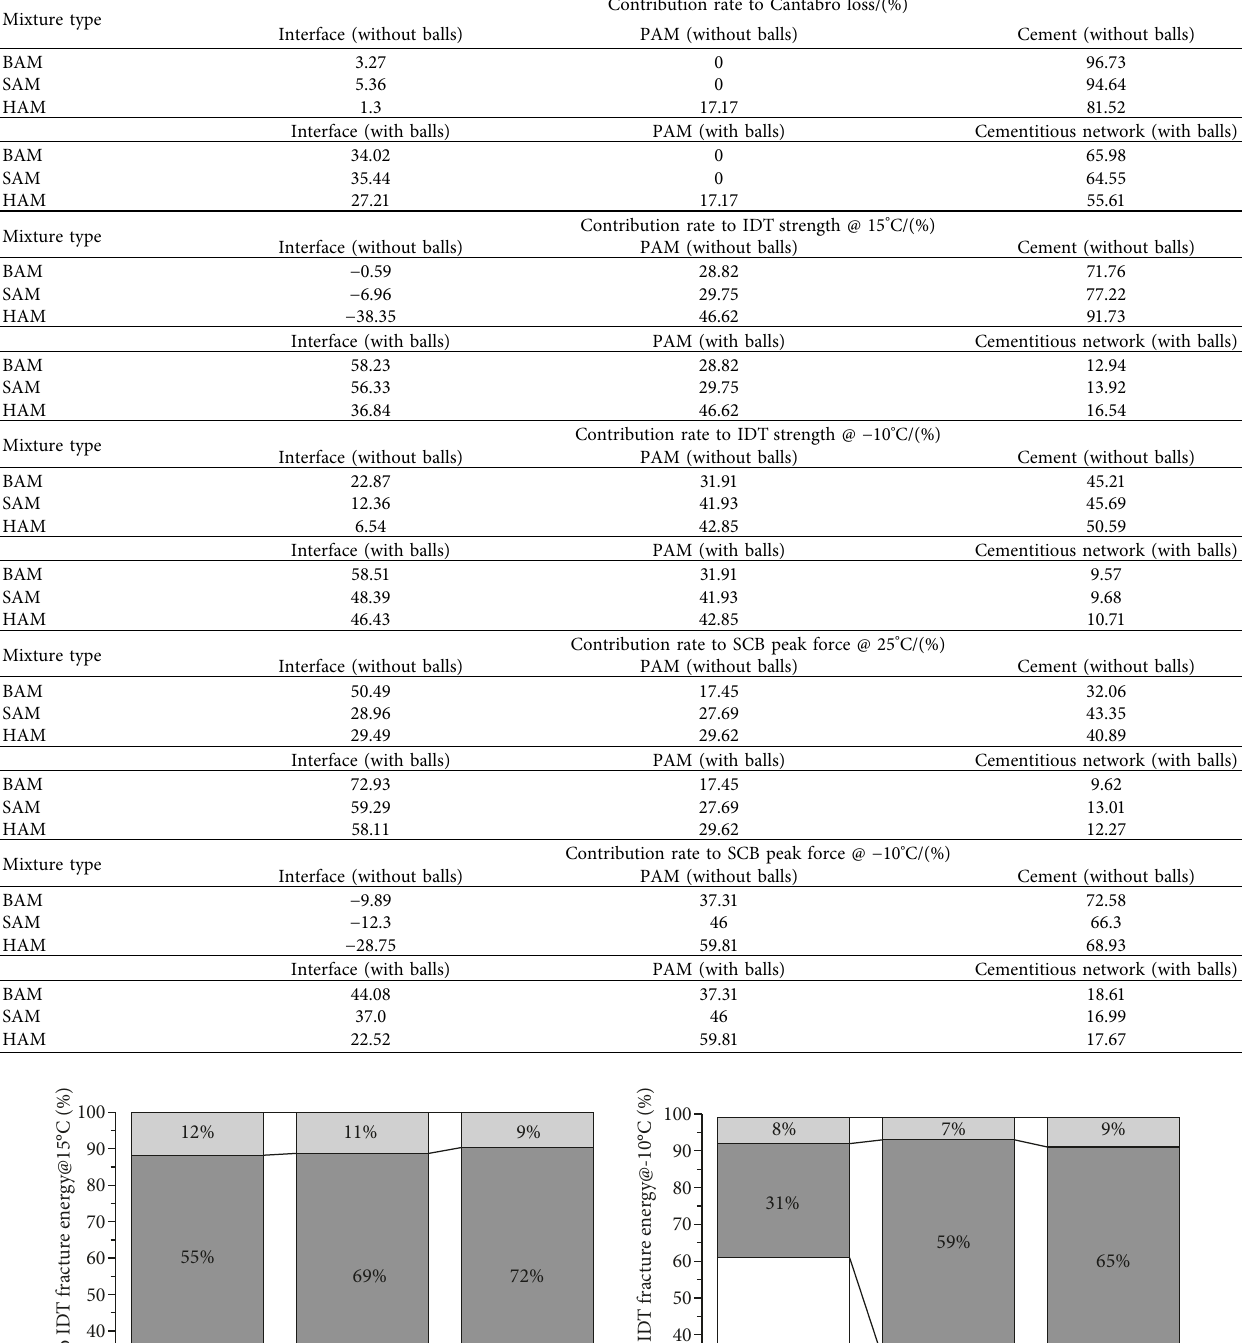
Table 7: Contribution rates of different phases to the mechanical properties of CCAM.